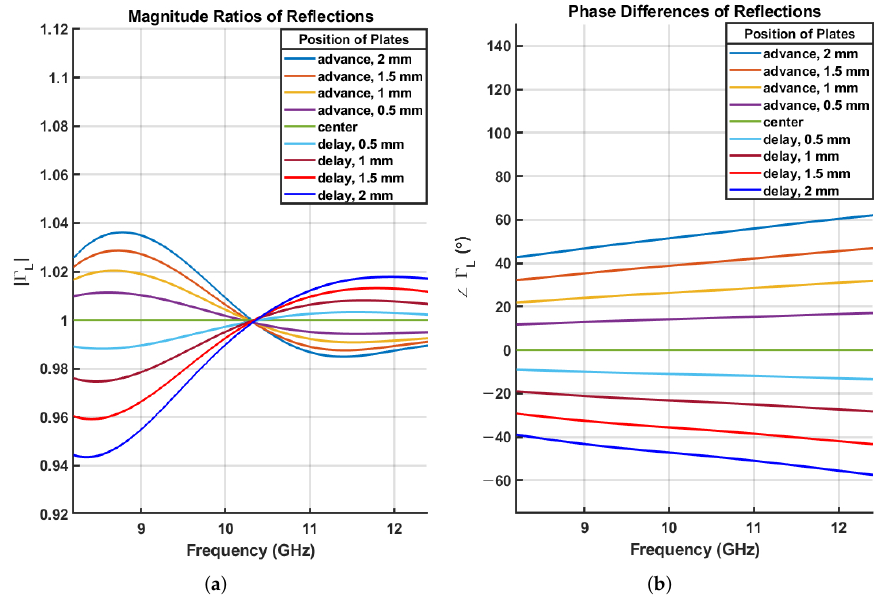
Figure 5. Variation in Γ L according to the position of the reflector. ( a ) Magnitude of Γ L . ( b ) Phase of Γ L